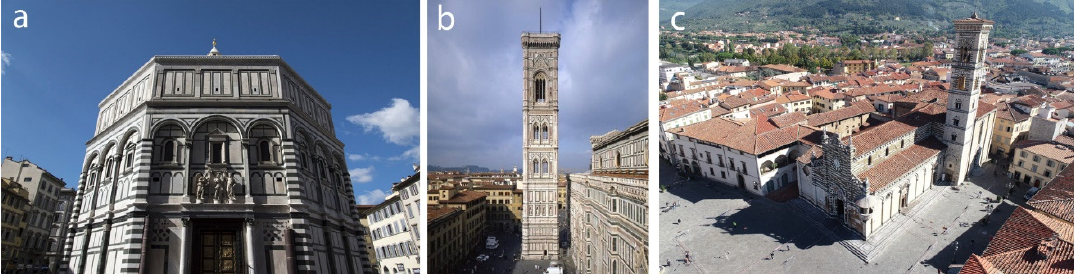
Figure 8 . General view of the historical monuments on which workflow has been applied: ( a ) Battistero di San Giovanni; ( b ) Campanile di Giotto; ( c ) Duomo di Prato. (Photos a and b by Opera del Duomo Website; photo c from authors).